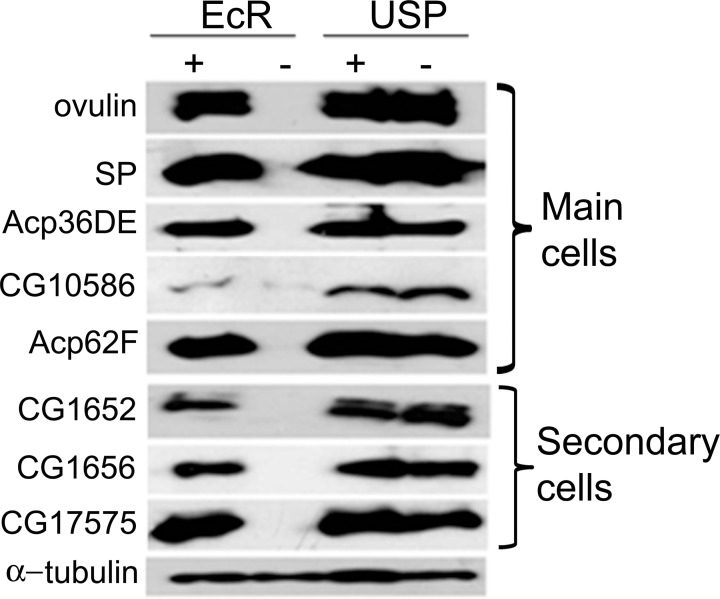
Main cell or secondary cell derived Acps in EcR or USP deficient male accessory glands.Depicted here are the western blots of accessory gland protein extracts from EcR control (+ lane under EcR), EcR knockdown (- lane under EcR), USP control (+ lane under USP) and USP knockdown (- lane under USP) males. All the Acps known to be derived from main cells (Ovulin, SP, Acp36DE, CG10586, and Acp62F) or secondary cells (CG1652, CG1656, CG17575) were detectable in EcR control, USP control and USP knockdown glands but not in EcR knockdown glands. α-tubulin was used as control for protein loading.